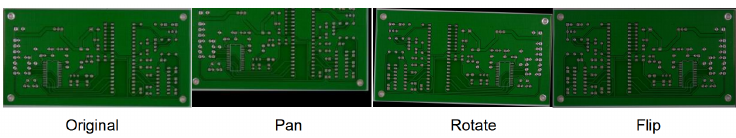
Figure 10. Enhanced image of PCB dataset.